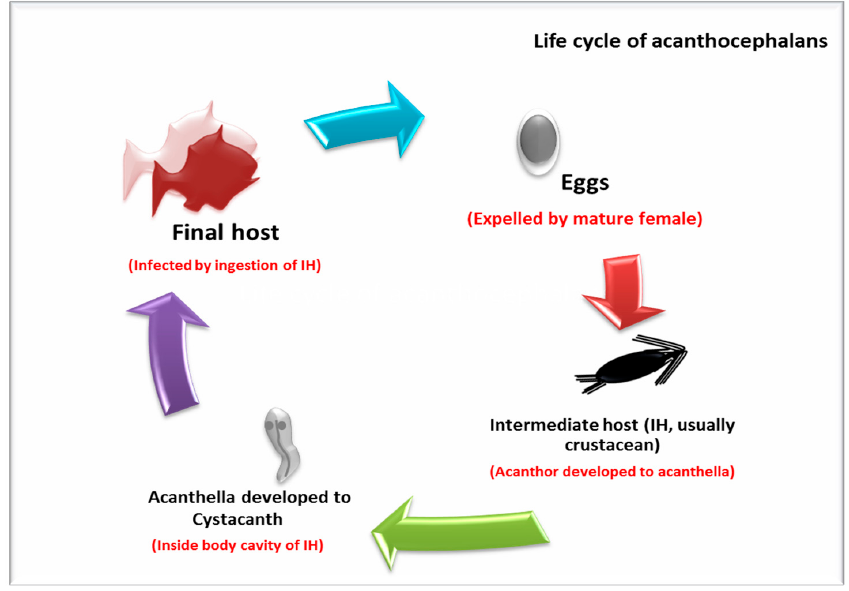
Figure 2. Life cycle of acanthocephalan.